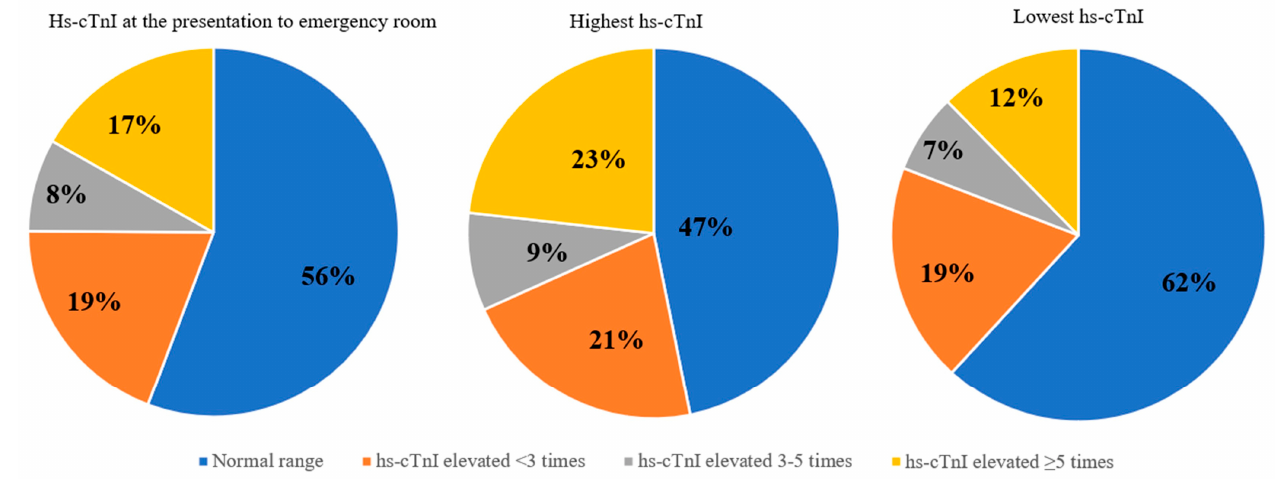
Figure 2. The proportion of normal range and elevated high sensitivity cardiac troponin-I values at the presentation to the emergency room, the highest and the lowest hs-cTnI values during hospital- ization. hs-cTnI—high sensitivity cardiac